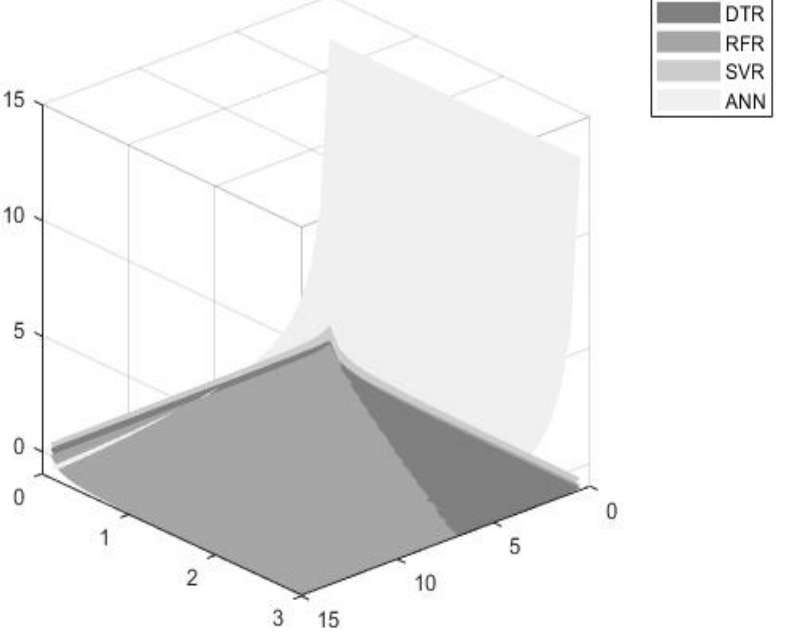
Figure 5. Sensitivity analysis of accuracy and time threshold values with w a = 40%, 1 − w a = 60%